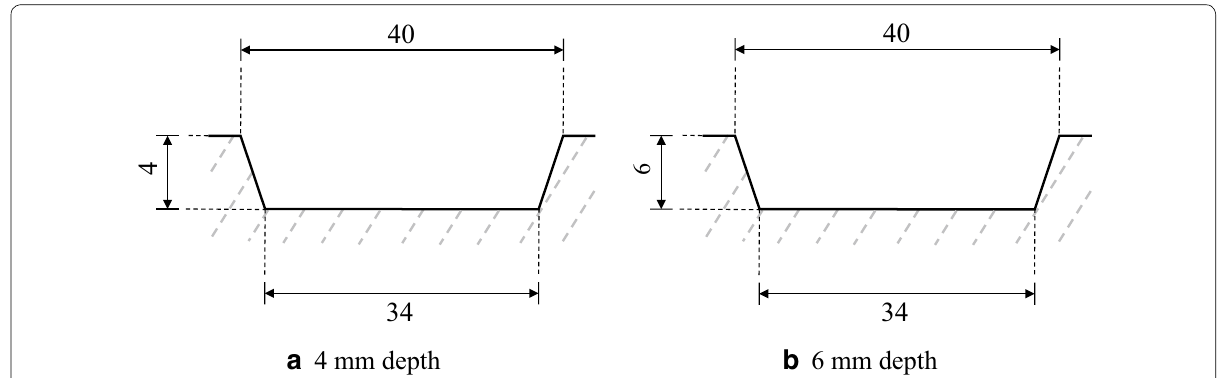
Fig. 3 Two different sizes of precast concrete interface groove: a 4 mm depth; and b 6 mm depth (units are in